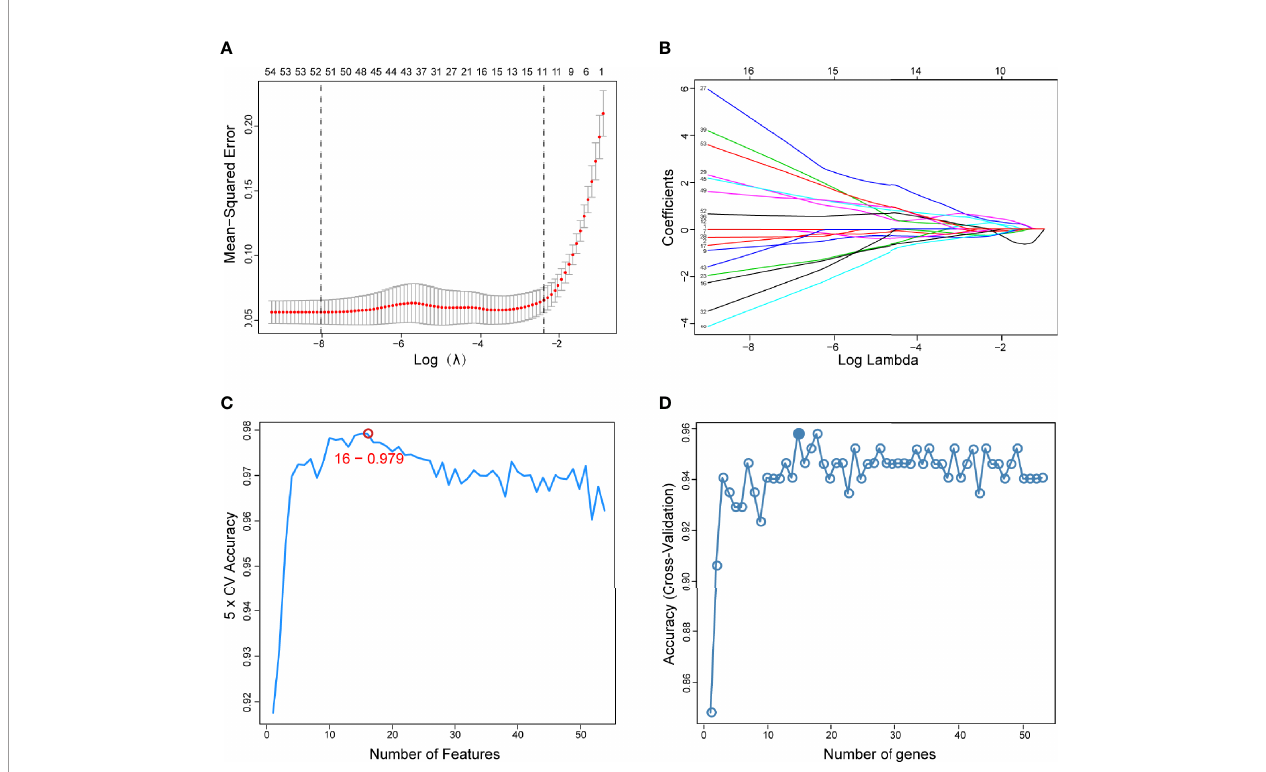
FIGURE 4 | Screening of diagnostic markers via the comprehensive strategy. (A) Least absolute shrinkage and selection operator (LASSO) logistic regression algorithm to screen diagnostic markers; (B) Different colors represent different genes; (C, D) Based on support vector machine-recursive feature elimination (SVM- RFE) and random forest (RF) algorithm to screen